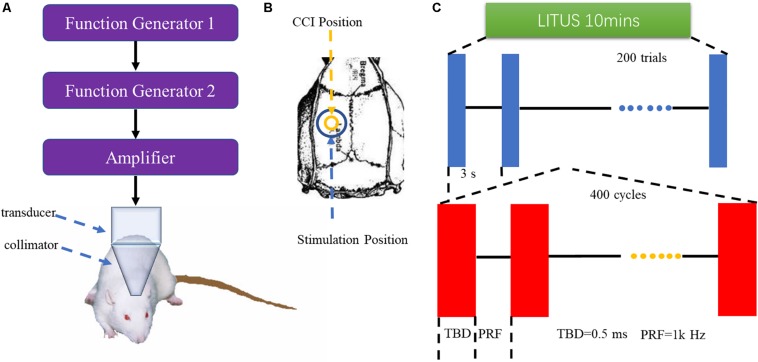
(A) LITUS system, two connected function generators were used to generate pulsed signals. The pulsed signal from the second generator was amplified by a linear power amplifier and transmitted to an unfocused ultrasound transducer. The ultrasound transducer was connected to the rat skin by a conical collimator with a diameter of 10 mm that was filled with ultrasound coupling gel. (B) Stimulation position and CCI position. (C) Time schedule of ultrasound stimulation and the parameters of the ultrasound.